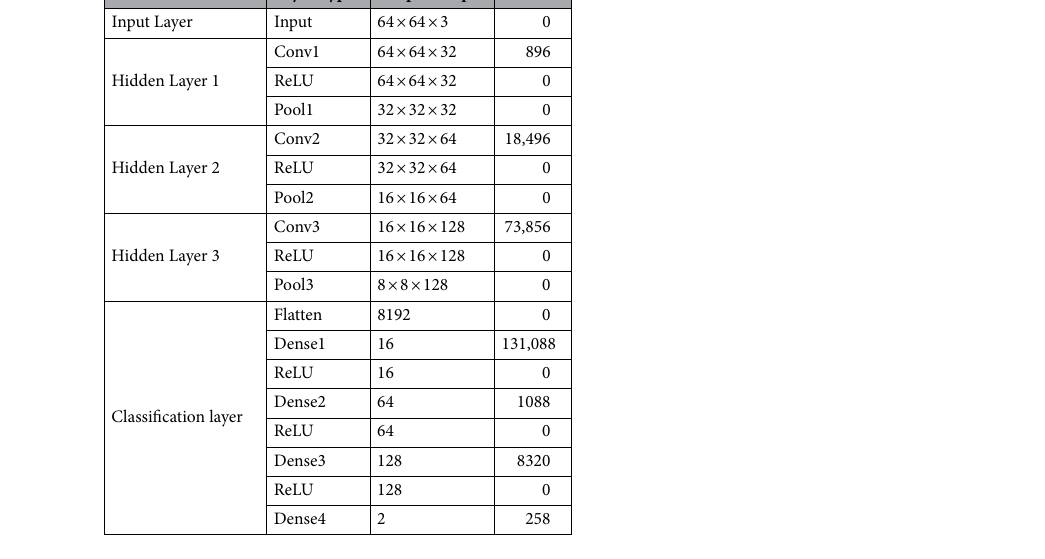
Table 1. The parameters of each level for